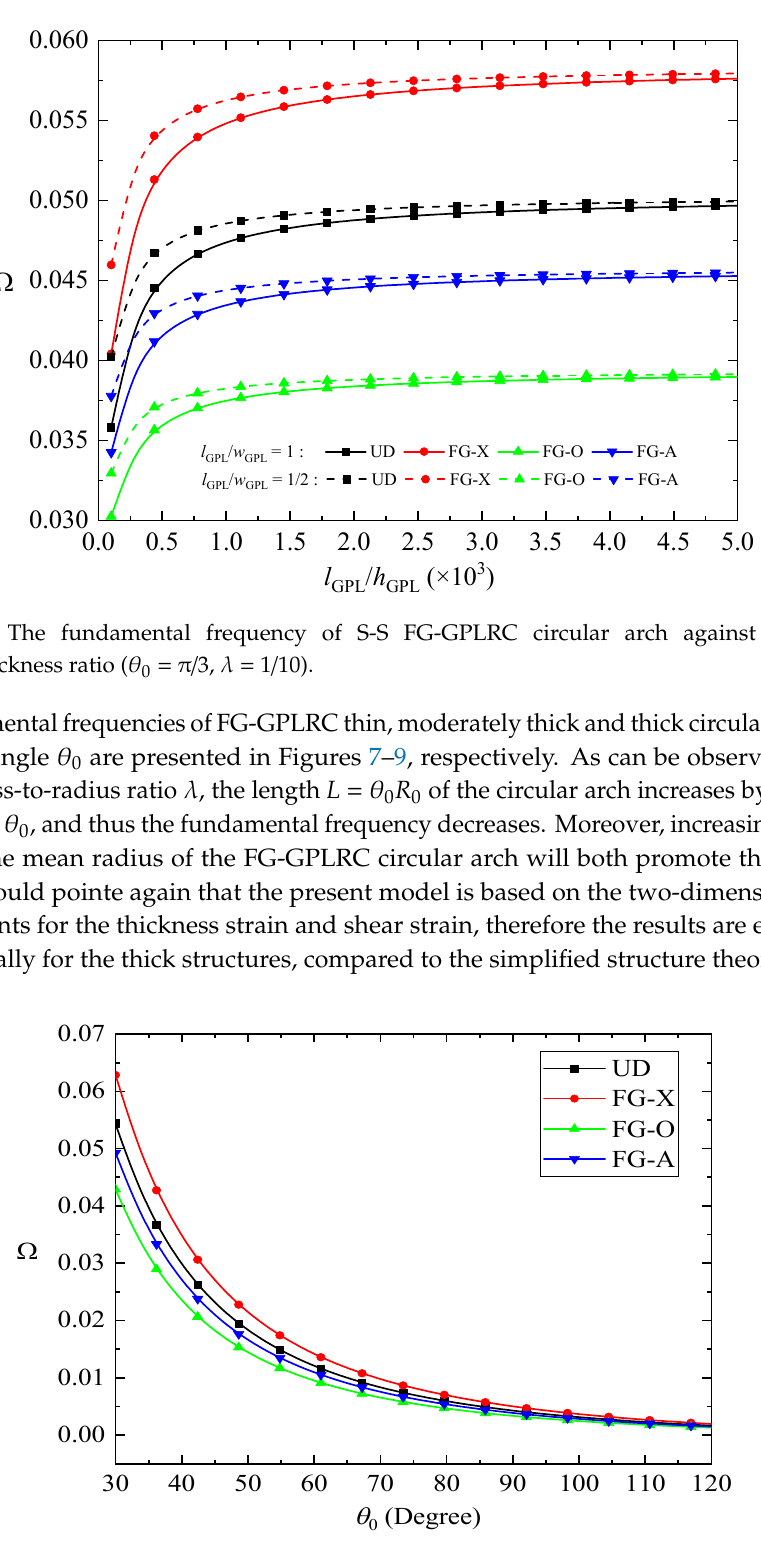
Figure 7. The fundamental frequency of S-S FG-GPLRC thin circular arch ( λ = 1 / 20) against the subtended angle θ 0